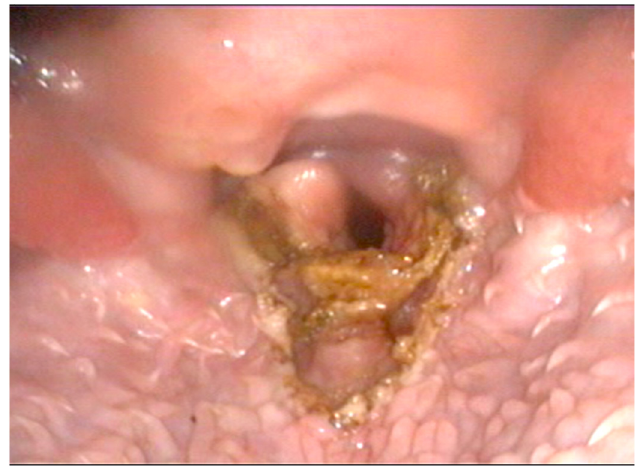
Figure 1. Larynx, immediate post-operative appearance: subtotal epiglottectomy and photoablation of the cuneiform process performed with the Airplasma device.